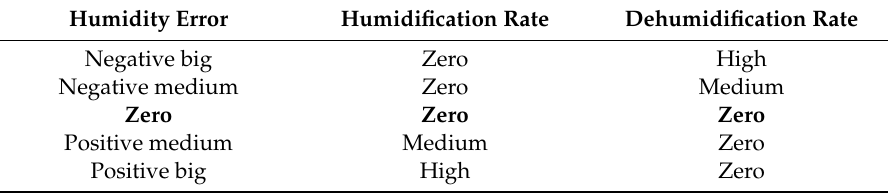
Table 2. Fuzzy rules for the humidity controller.